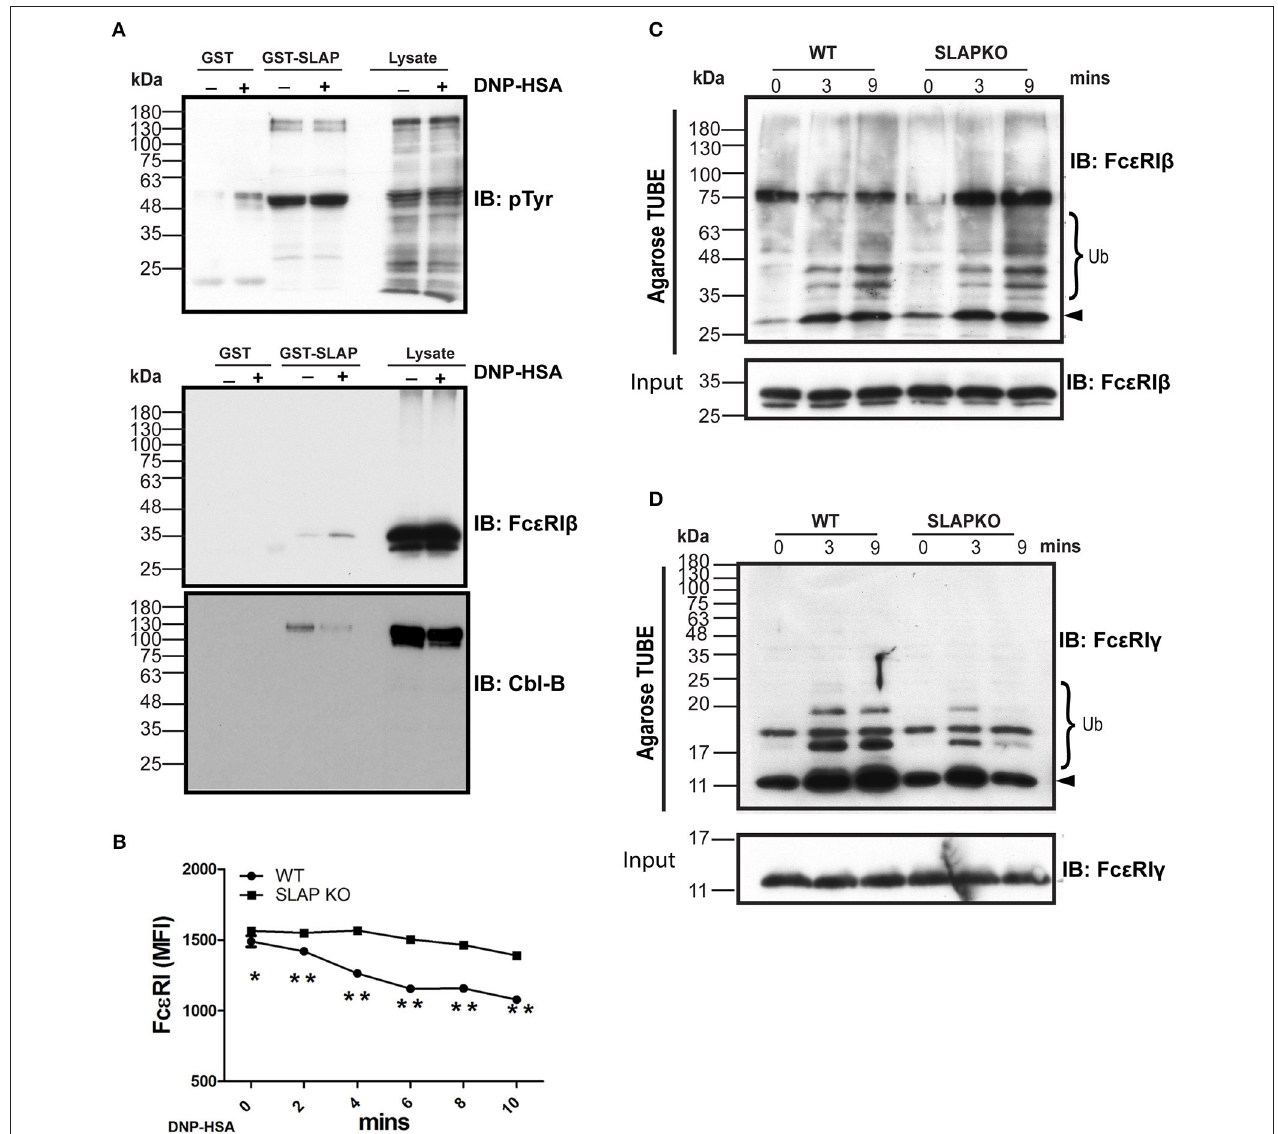
FIGURE 8 | SLAP interacts with Fc ε RI β chain and Cbl-B and regulates Fc ε RI internalization and ubiquitination. (A) GST-SLAP fusion protein was incubated with RBL-2H3 lysates and bound proteins were analyzed by immunoblot with anti-phosphotyrosine (pY), anti-Fc ε RI β chain, and Cbl-B Abs. Results are representative of three separate experiments ( n = 3). Positions of relative mass markers in kilodaltons (kDa) are shown on the left. (B) Sensitized WT and SLAP KO BMMCs were stimulated with DNP-HSA (20ng/ml) for the indicated time-points and stained with anti-IgE antibody to quantify surface level of Fc ε RI receptor. Line graph shows the MFI of Fc ε RI at indicated time points. Data shown are the means ± SD values from a representative experiment done in triplicate, out of three independent experiments ( n = 3). A significant difference was observed between genotypes (Student’s t -test; * P < 0.05; ** P < 0.01). Lysates obtained from sensitized and stimulated WT and SLAP KO BMMCs for indicated times were incubated with ubiquitin binding domain linked agarose (Agarose TUBE) to pull down ubiquitylated proteins. Representative immunoblots showing the ubiquitinated (C) Fc ε RI β , and (D) Fc ε RI γ chains at indicated times. Results are representative of two independent experiments ( n = 2). Positions of relative mass markers in kilodaltons (kDa) are shown on the left. Ub indicates the ubiquitinated species and arrowhead shows the indicated protein band at the respective molecular